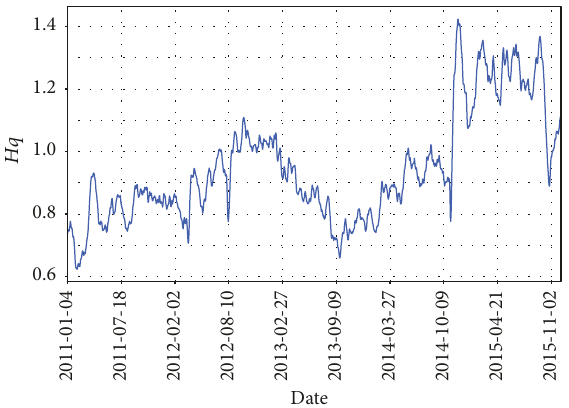
Figure 11: Time varying scaling exponents for 𝑞 = 2 for mass media news amount and new media amount.